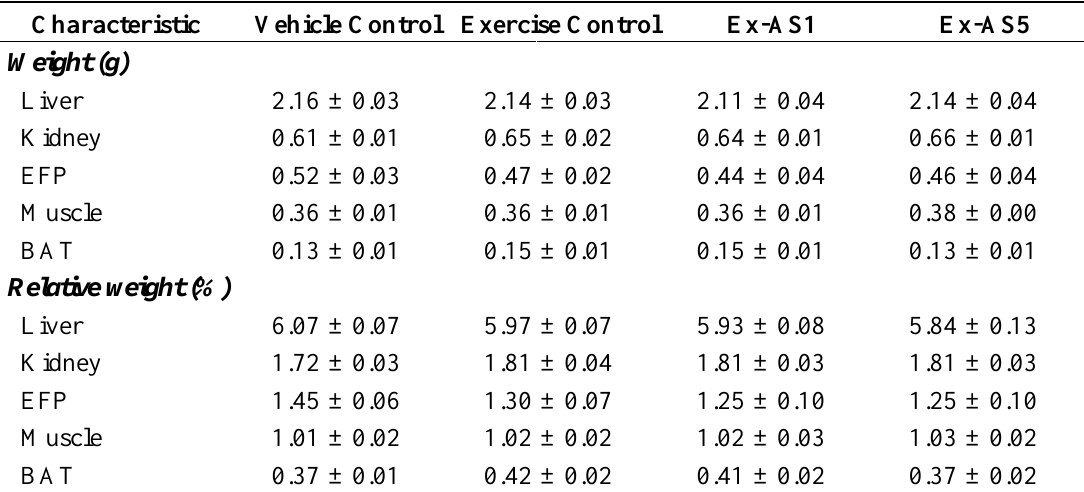
Table 1. General characteristics of the experimental